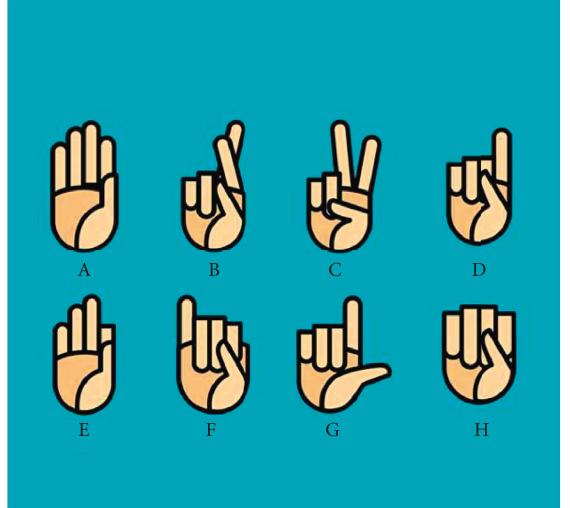
Figure 7: Defining 8 gestures.